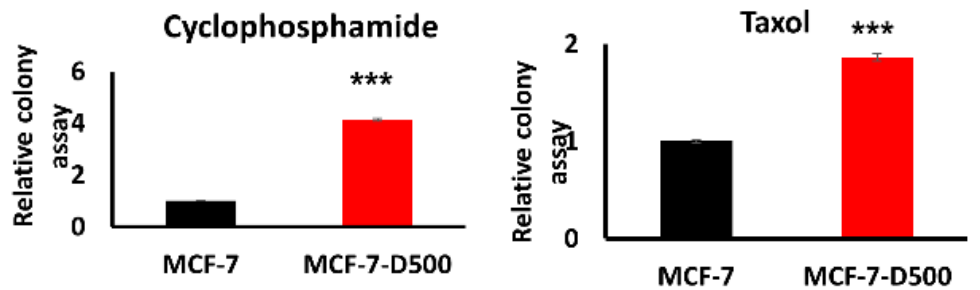
Figure 2. MCF-7-D500 cells with multidrug resistance. ( A ) The cell colony formation ability of MCF-7 and MCF-7-D500 cells was examined after treatment with various chemotherapeutic drugs, including doxorubicin, 5-FU, carboplatin, cyclophosphamide, and taxol. ( B ) The colony formation ability was quantified (*** p < 0.001).